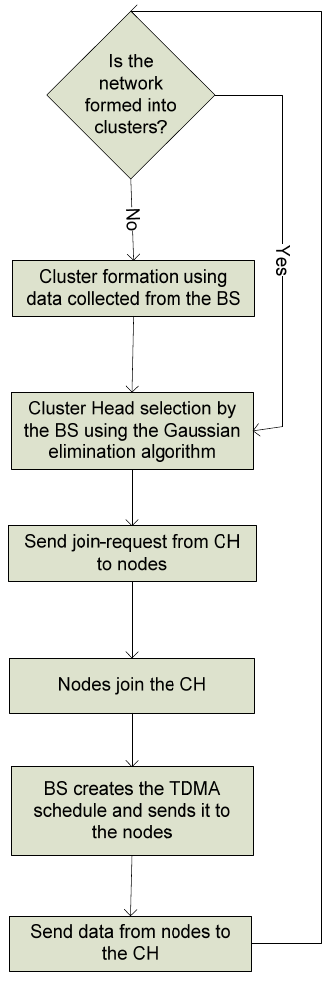
Figure 2. Cluster formation and data sending in